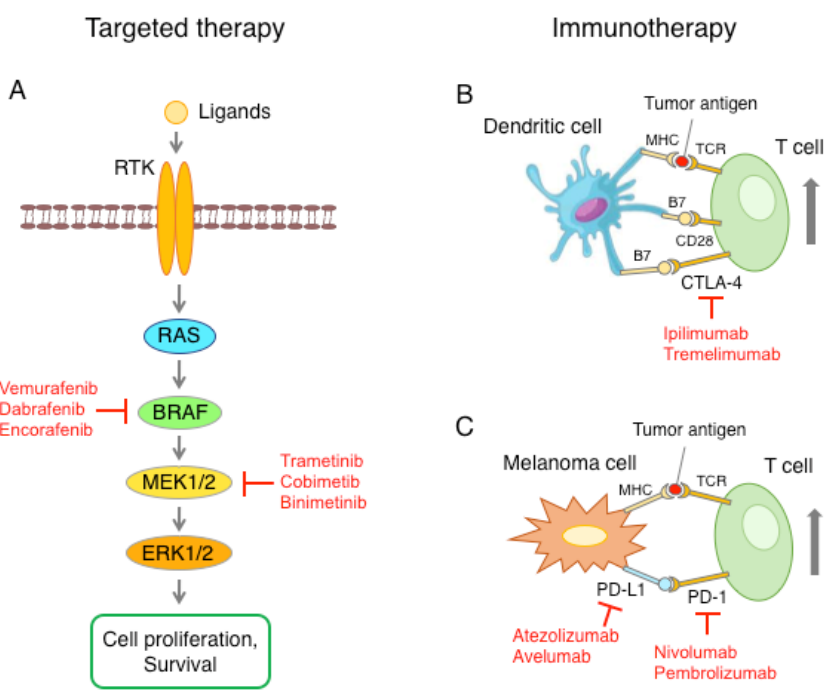
Figure 2. Schematic representation of the main therapeutic approaches against melanoma. ( A ) The RAS-RAF-MEK1/2-ERK1/2 pathway is often upregulated in melanoma, with a consequent increase in cell proliferation and survival. Pharmacological inhibition of mutant BRAF or kinase MEK1/2 blocks the MAPK pathway. ( B ) Activation of T cells requires presentation of the tumor antigen to the T-cell receptor (TCR) through the major histocompatibility complex (MHC) and the interaction of CD28 with B7 ligand, present on the surface of dendritic cells. T cells also express CTLA-4, whose binding to B7 triggers the signal to inactivate T cells. Anti-CTLA-4 antibodies inhibit the interaction between CTLA-4 and B7, leading to T cell activation. ( C ) Melanoma cells can express high levels of PD-L1, which, through the interaction with the PD-1 receptor on the T cells, causes a reduction in T cell function. Blockade of the PD-L1/PD-1 axis with anti-PD-1 or anti-PD-L1 checkpoint inhibitors restores the ability of T cells to recognize and destroy melanoma cells.